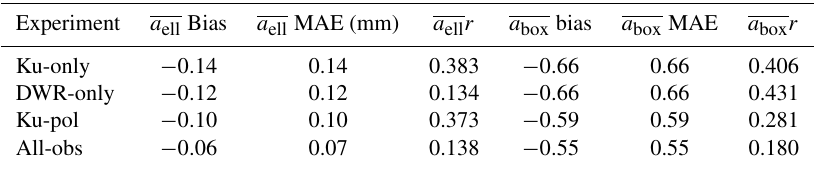
Table 9. Mean bias, absolute error (MAE), and correlation coefficient ( r ) of PIP-derived versus D3R-estimated mean area-weighted ellipse ( a ell ) and box ( a box ) aspect ratio for each of the four retrieval